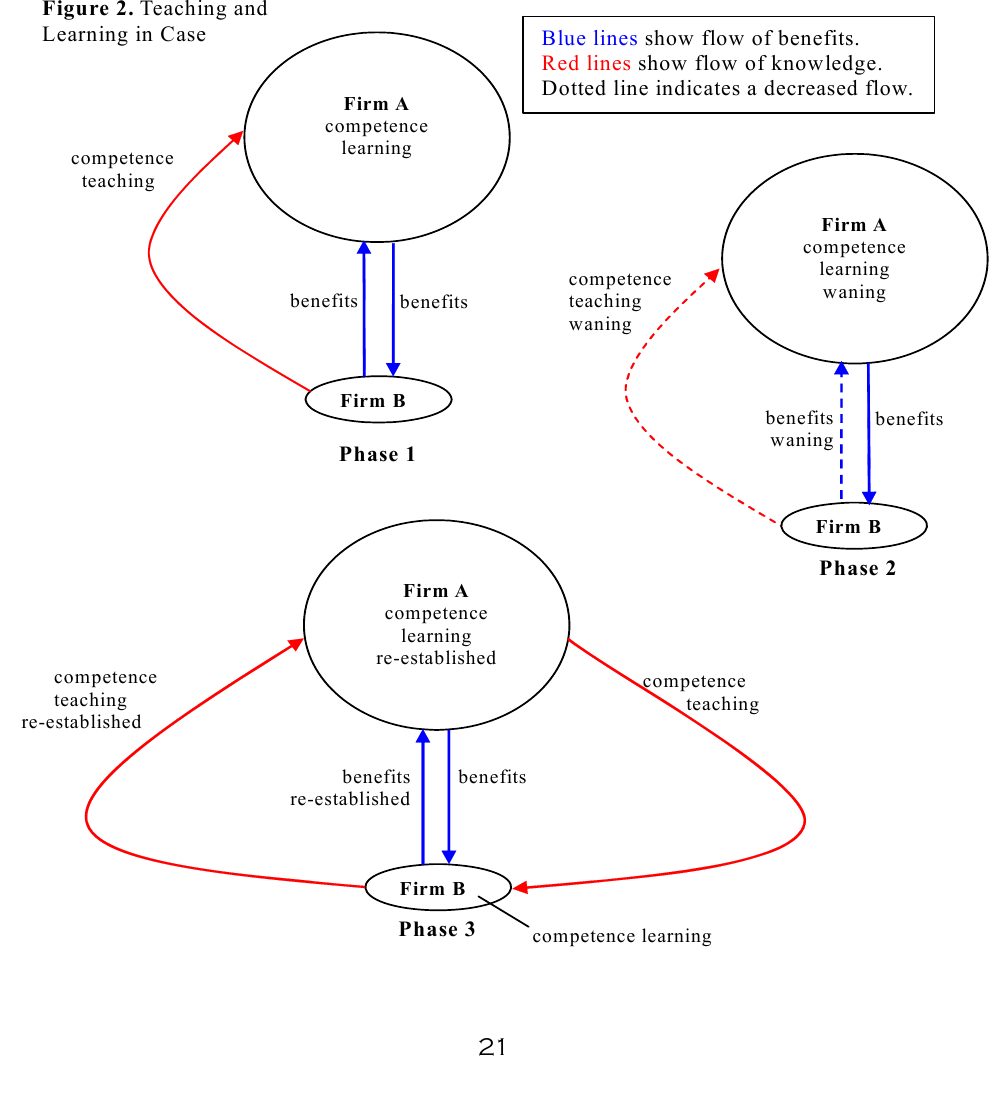
Blue lines show flow of benefits. Red lines show flow of knowledge. Dotted line indicates a decreased